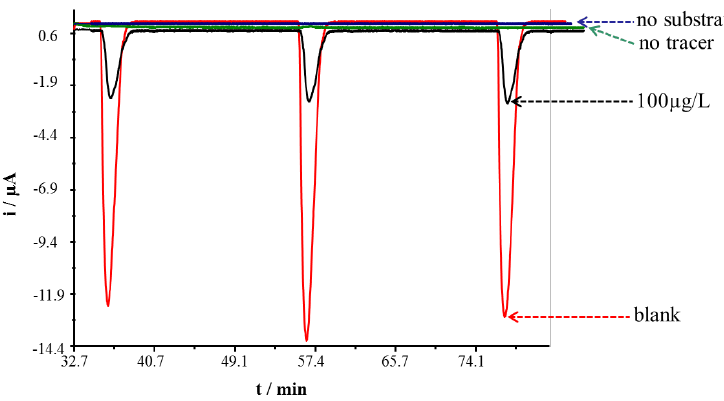
Figure 5. Assay confirmation on different conditions (no substrate, no tracer, 100 µg/L MCLR and PBS (10 mM phosphate buffer containing 50 mM NaCl, pH 7.4) as the blank).